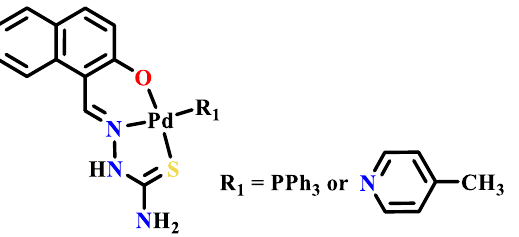
Figure 27. Two palladium(II) complexes of naphthylhydrazone with thiourea as a side chain along with PPh 3 or p -methylpyridine as co-ligands. with PPh 3 or p -methylpyridine as